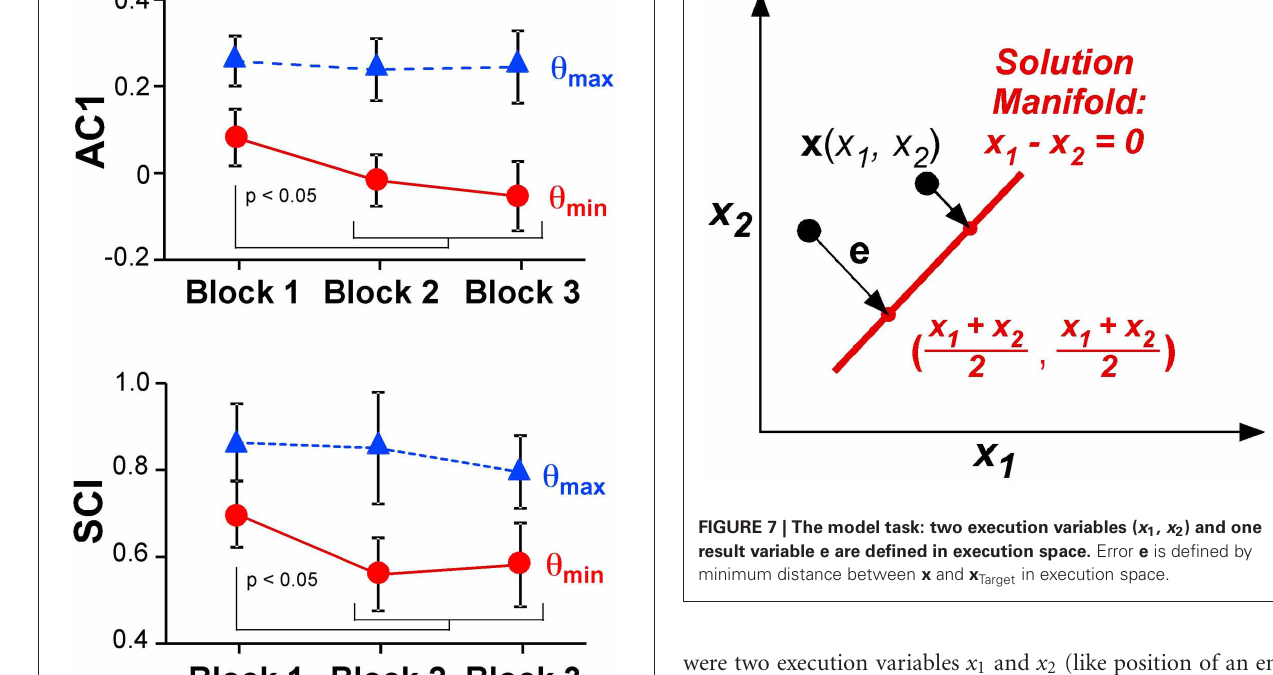
π /2 rad, respectively. Results showed that for both AC1 and for